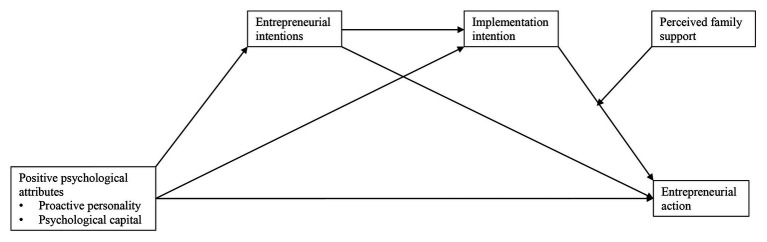
Conceptual model.